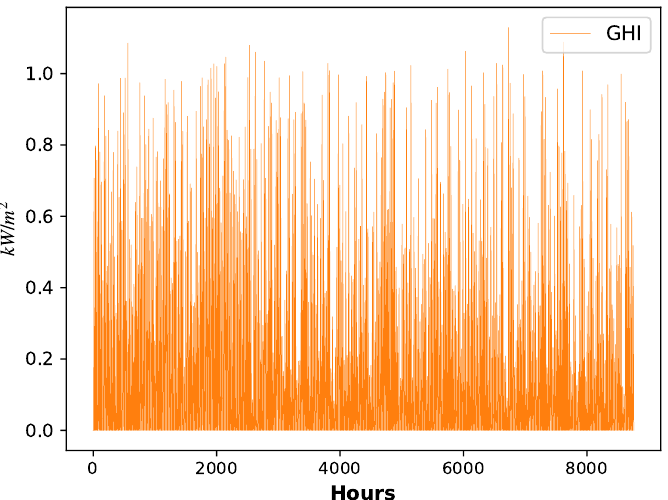
Figure 4. Yearly electrical demand.